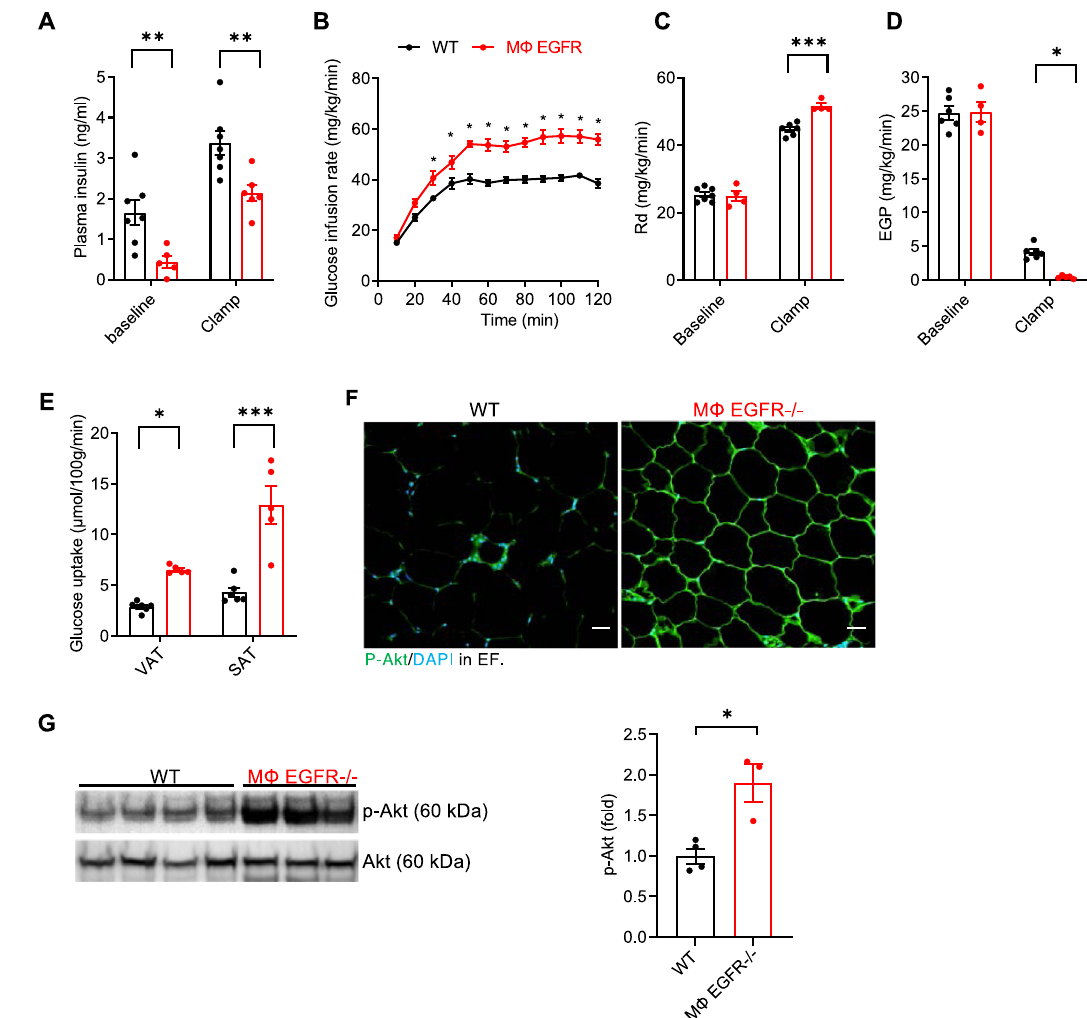
Fig.4|MicewithselectiveEGFRdeletioninmyeloidcellsselectivelyattenuated white adipose tissue insulin resistance in diet-induced obesity. Hyperinsulinemic-euglycemic clamps were performed on 5h fasted WT and M Φ EGFR − / − mice after 12 weeks on the HFD. A M Φ EGFR − / − mice had lower plasma insulinlevelsat baseline and during clamp periods. N =5 and 7. B M Φ EGFR − / − mice hadlesssevereinsulinresistance,asmoreglucoseinfusionwasneededtomaintain aconstantbloodglucose. N =5and7. C , D .M Φ EGFR − / − micehadincreasedratesof glucose disappearance (Rd) ( N =4 and 7) C and decreased endogenous